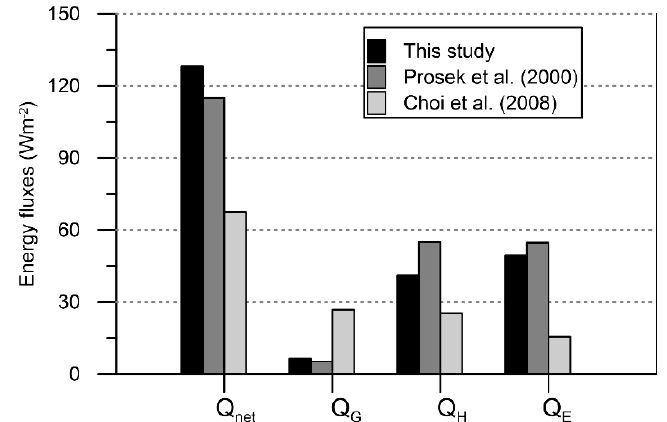
Figure 7. February mean net radiation (Q net ), ground heat flux (Q G ), sensible heat flux (Q H ) and latent heat flux (Q E ) on James Ross Island (this study) and King George Island according to studies by Prosek et al. [17] and Choi et al. [13].